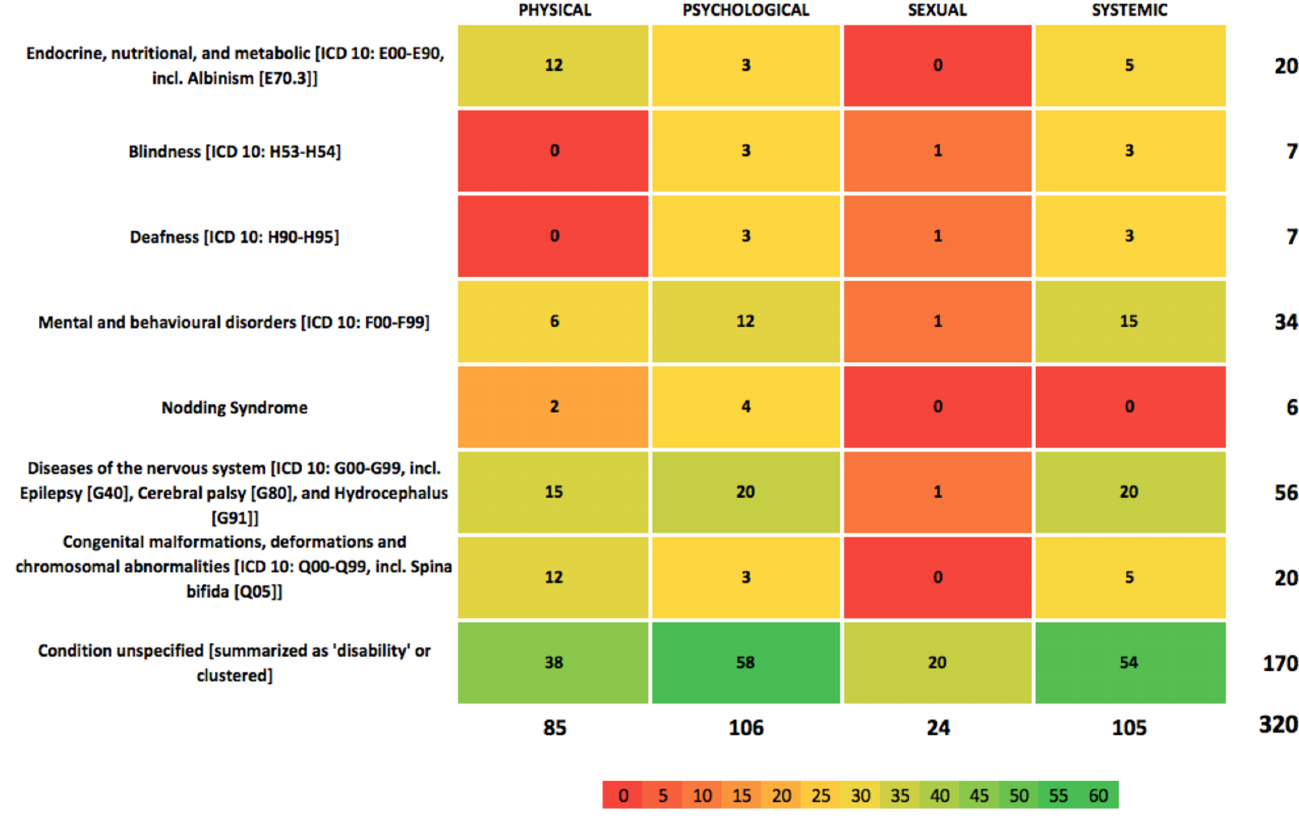
PLOS ONE | https://doi.org/10.1371/journal.pone.0184541 September 11,